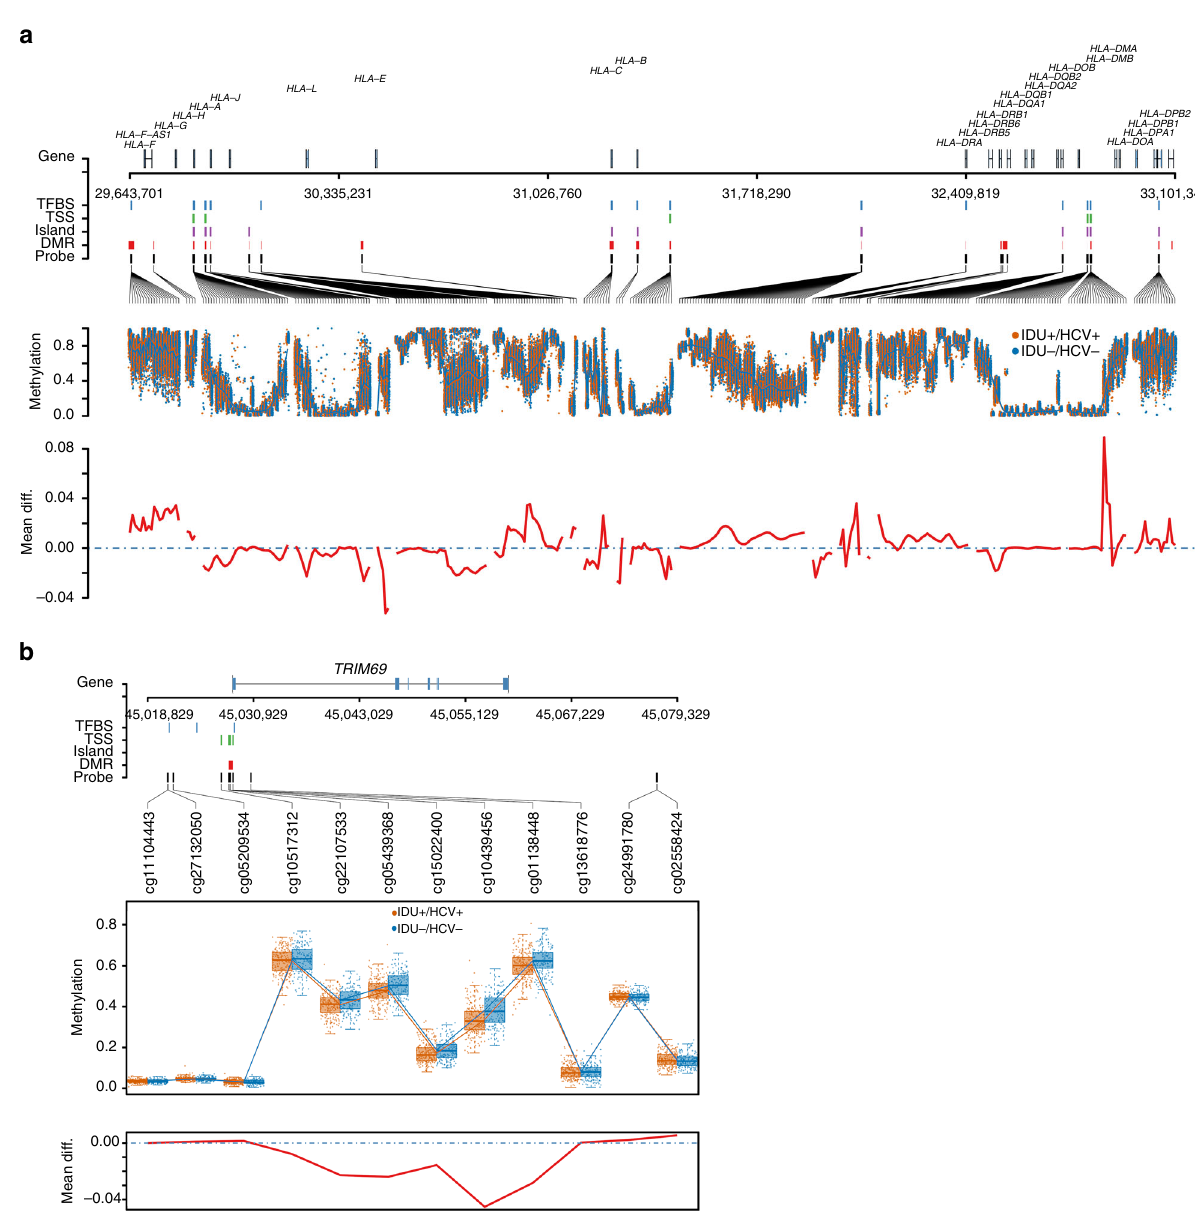
This result suggests that the methylation panel obtained from EWAS can differentiate two phenotypic groups without other signi fi cant confounding effects. infected individuals, we constructed a methylation cumulative score based on a weight sum of adding residual methylation